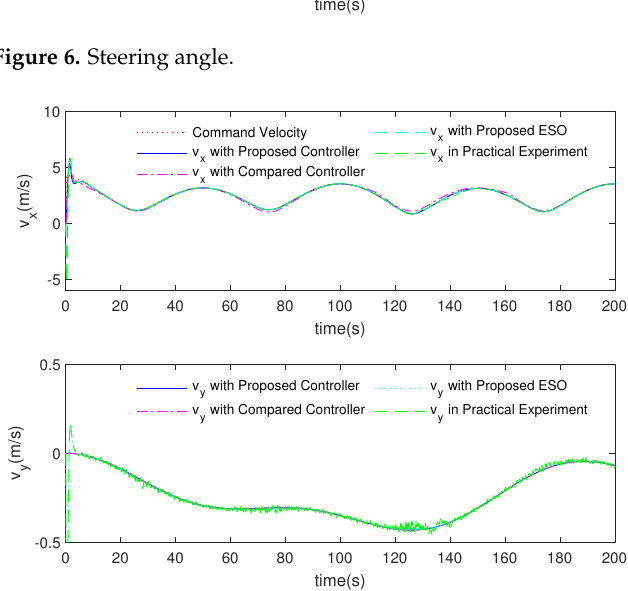
Figure 7. Velocities in tracking control.